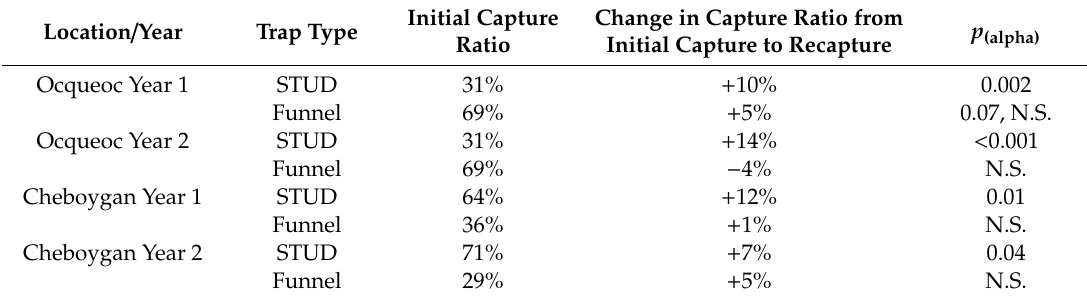
Table 2. Distribution of lamprey caught, marked, and recaptured in two trap types in the Ocqueoc and Cheboygan Rivers. Column 3 shows the initial distribution of catch in each trap. Column 4 shows by how much the ratio in Column 3 di ff ered in the recaptured individuals (see text for details). The p -values are for Chi-squared goodness-of-fit